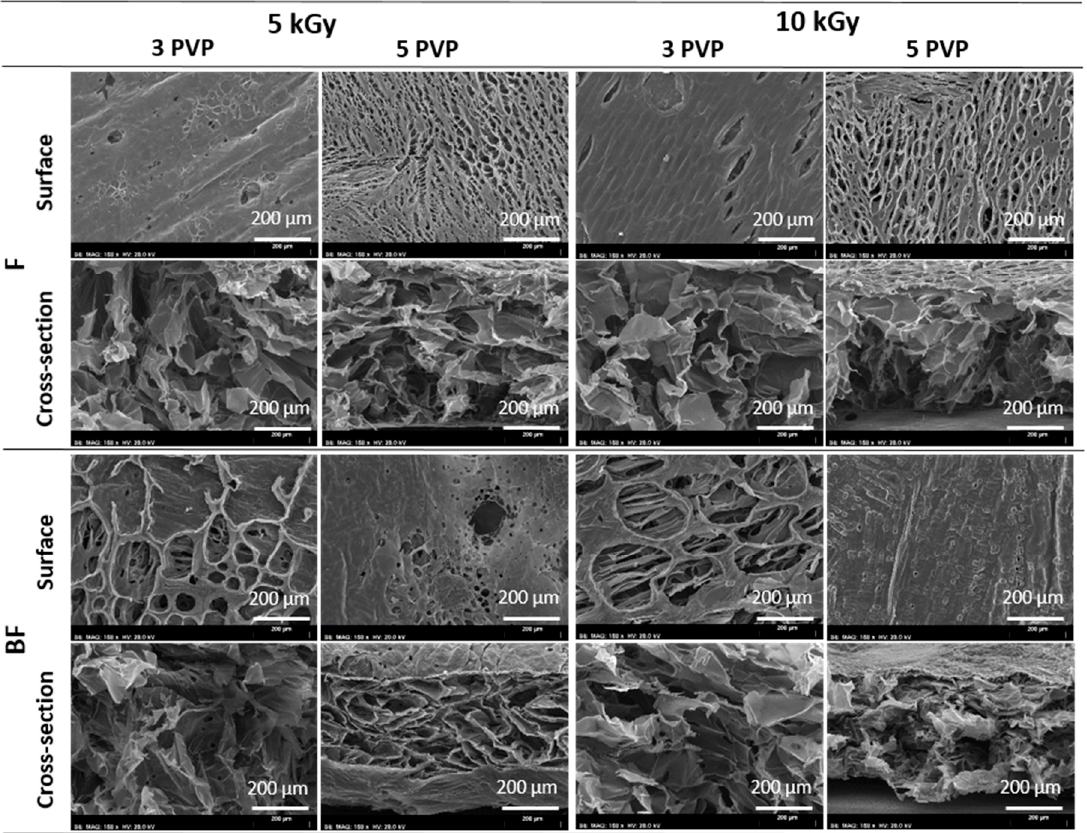
Figure 2. Surface and cross-sectional SEM micrographs of the chitosan/PVP matrices obtained at different experimental conditions: with and without N 2 bubbling (BF and F), different PVP content (3% and 5%) and different radiation dose (5 and 10 kGy).